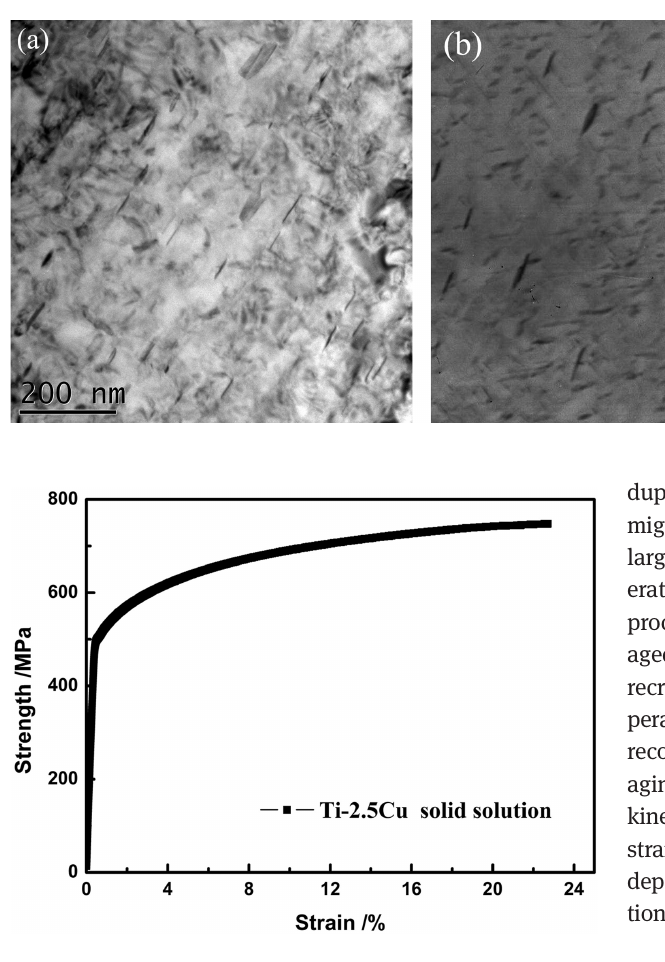
Figure 3: Engineering stress-strain curve for the solid solution Ti-2.5Cu alloy. The yield strength and elongation of Ti-2.5Cu alloy with different prestrain subjected to first (673 K~24 h) and duplex aging (673 K~24 h + 748 K~8 h) was shown in Figure 4. The strength monotonically increases with pre- strain for first aging. However, the strength firstly increases and then decreases for the prestrain samples after duplex aging. As the prestrain exceeds 15%, the strength after